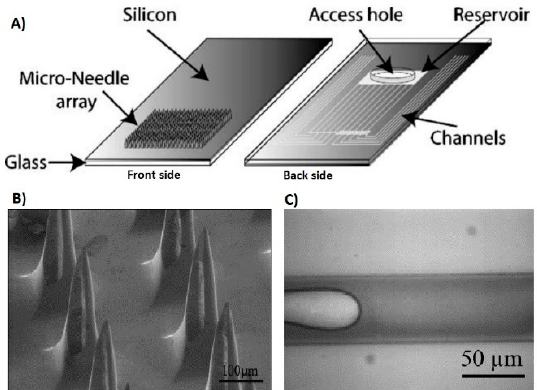
Figure 5. ( A ) Structure of microneedle Array, ( B ) SEM image of Snake Fang microneedle design, ( C ) Transdermal extraction leading to interstitial fluid in micro channels [85].